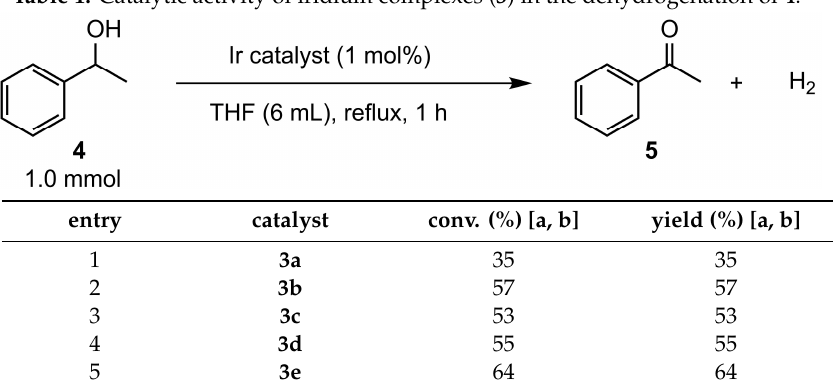
Table 1. Catalytic activity of iridium complexes ( 3 ) in the dehydrogenation of 4 .